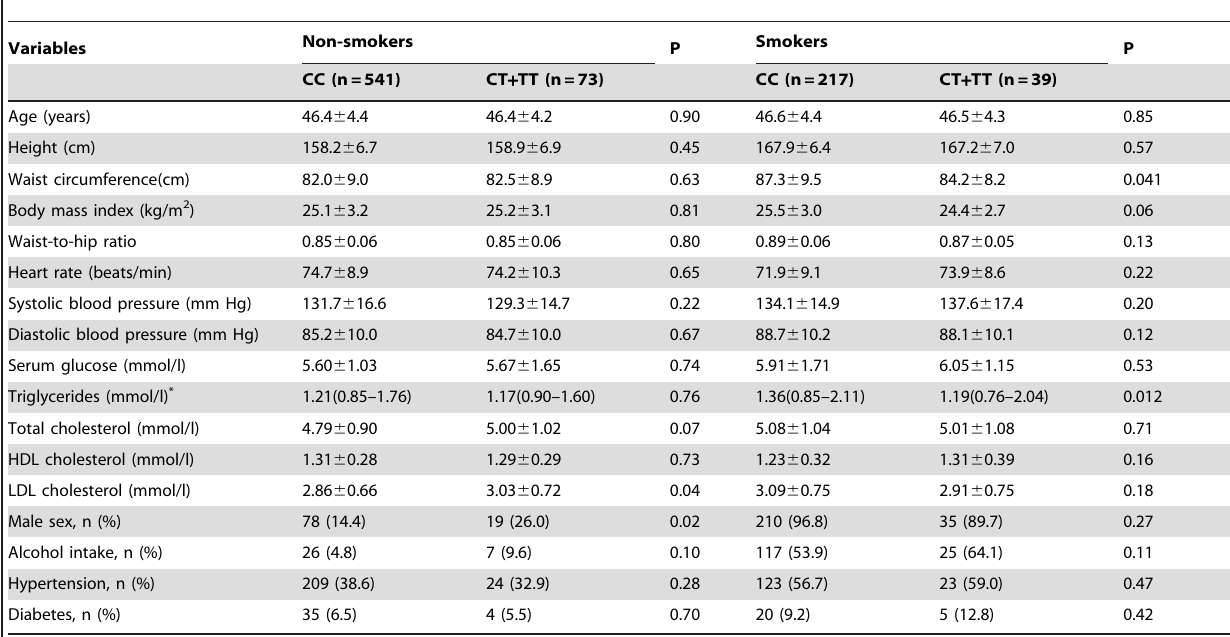
Table 1. Characteristics of the study groups stratified by genotype among smokers and nonsmokers.